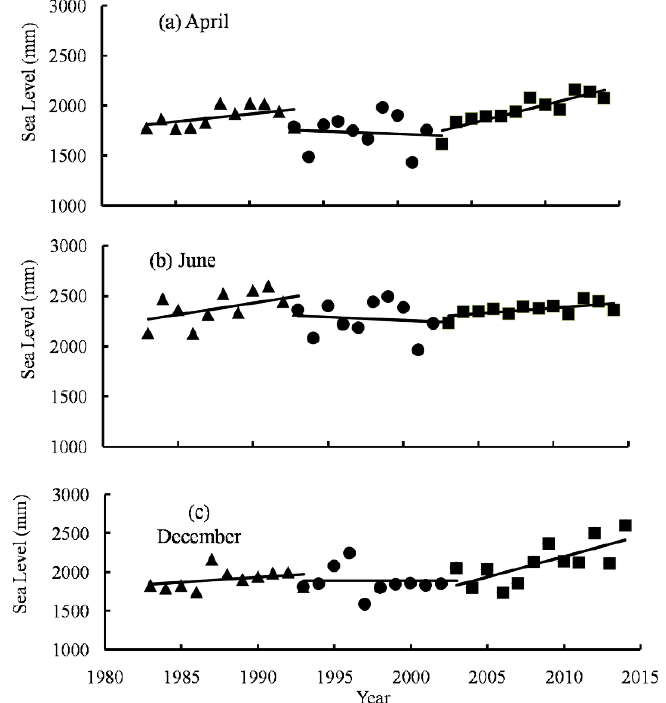
Figure 8. Sea level variation for the months of April, June, and December from 1983 to 2014. Solid straight line represents the trend. Triangles, circles and squares are the mean yearly sea levels of the designated months for the period of 1983−1993, 1993−2003 and 2003−2014, respectively.